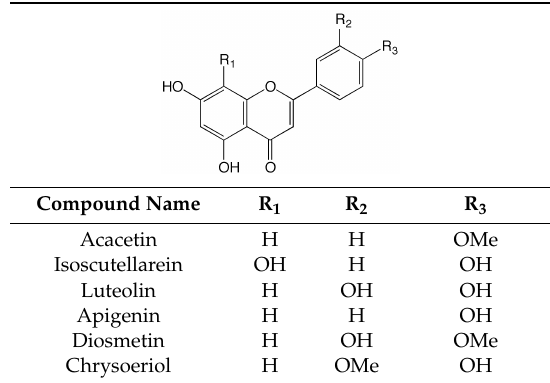
Figure 2. Core skeleton of the flavonoid subclasses generally found in Citrus fruits and juices. Table 1. Flavone aglycones occurring in Citrus spp.